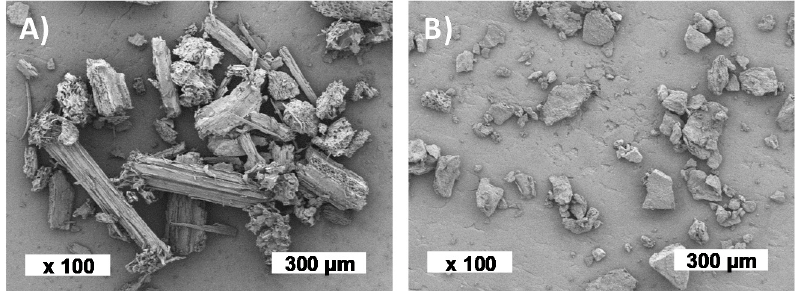
Figure 1. SEM images of ( A ) the vine shoots and ( B ) the wine pomace fillers. Table 2. Filler density and apparent diameter (in